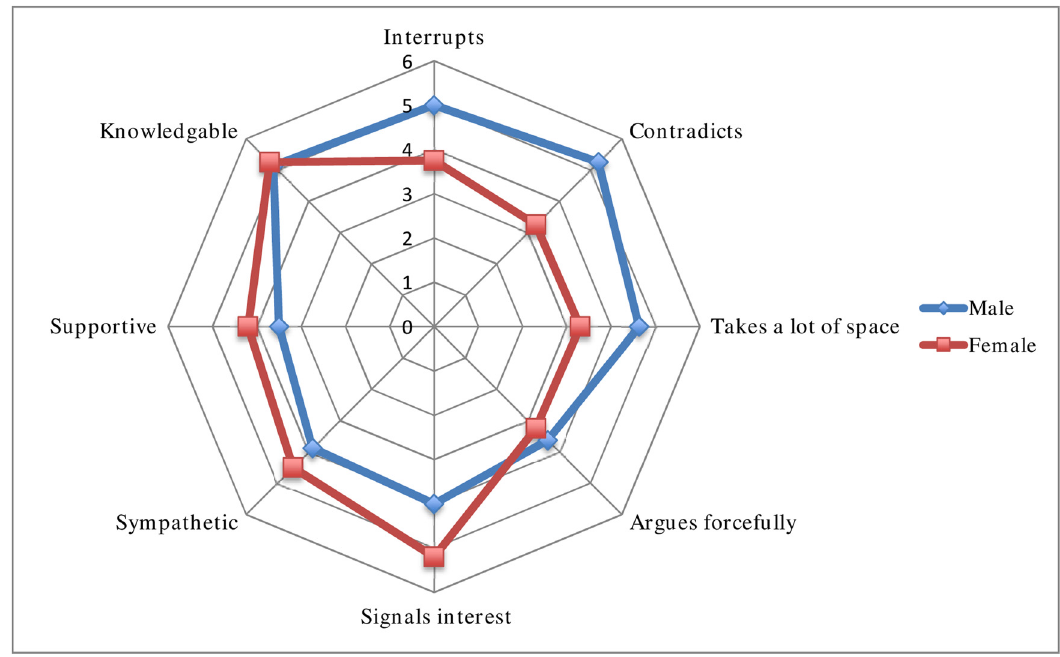
Figure 2: Response patterns ( 7 - point Likert scale ) to statements of conversational behaviour of Speaker A, male and female manipulations ( n = 134 ) . Red represents responses to the female version of the recording while blue represents responses to the male